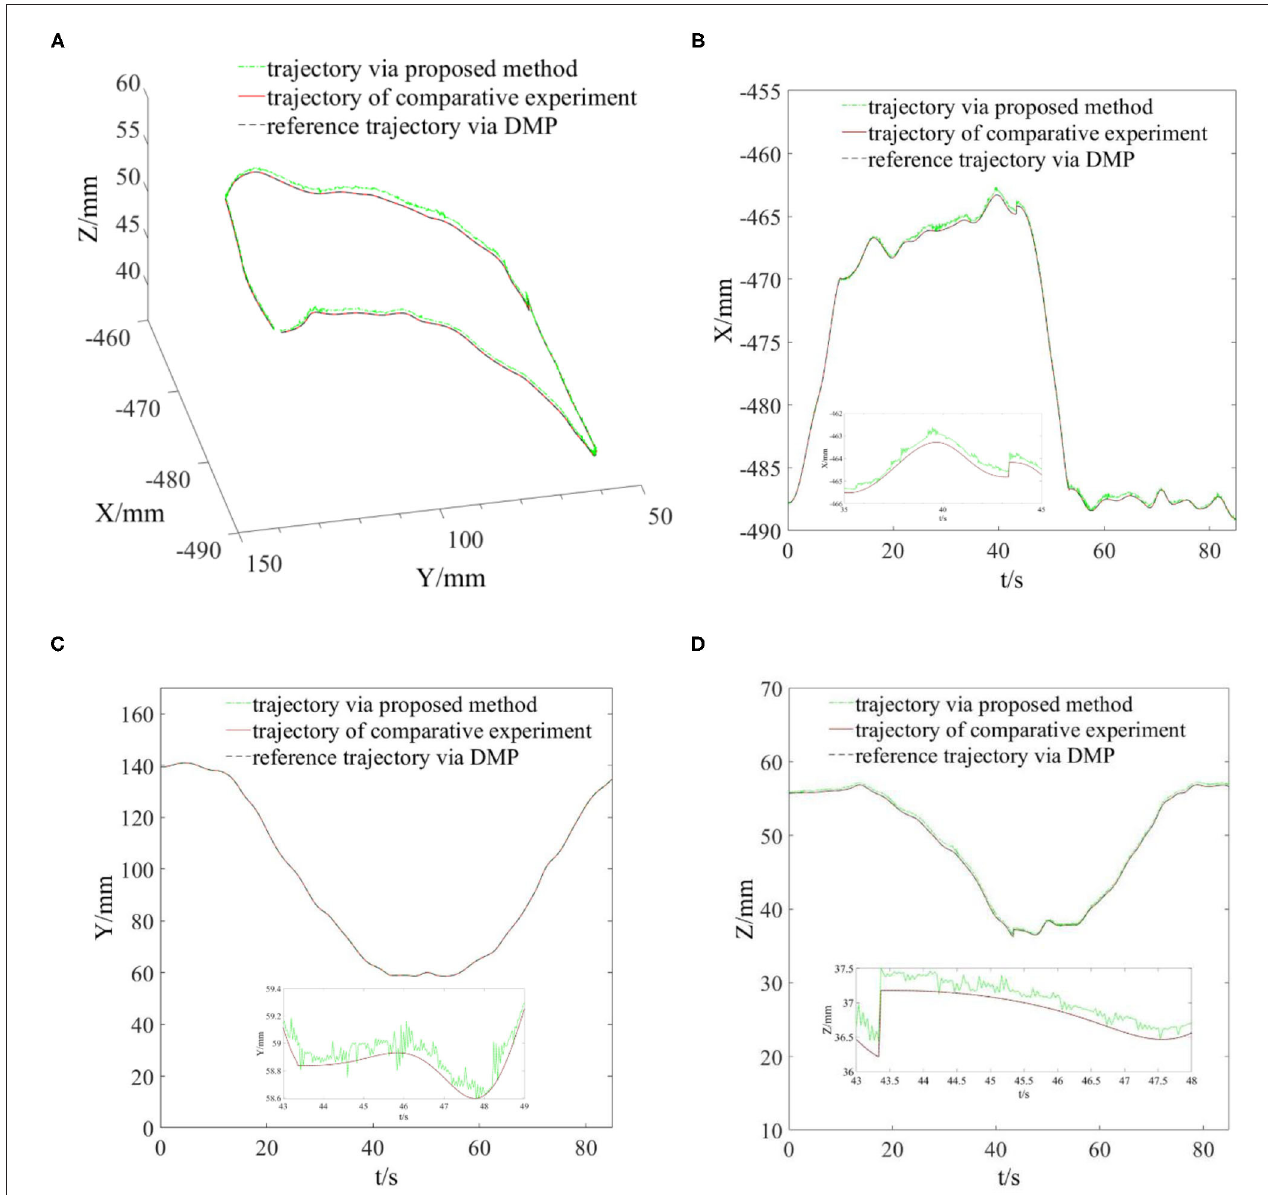
FIGURE 6 | Reference and actual grinding trajectories of two experiments. (A) Spatial view of grinding trajectories. (B) Grinding trajectories in the X direction. (C) Grinding trajectories in the Y direction. (D) Grinding trajectories in the Z